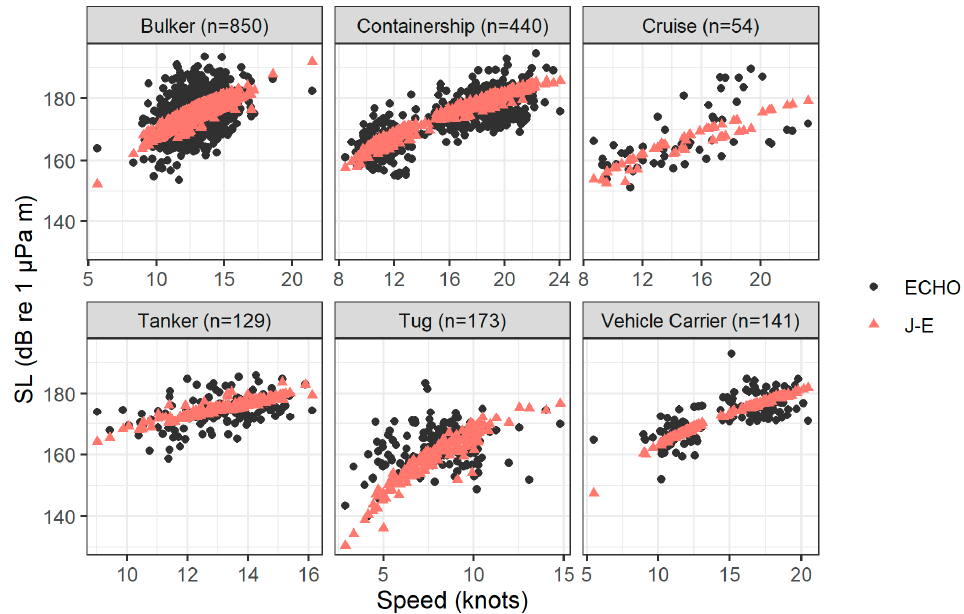
Figure 5. Scatter plots of predicted and observed (ECHO) source levels versus speed, in the 63 Hz decidecade band, for the JOMOPANS-ECHO (J-E) model, for six vessel types. The n value in each panel indicates the number of measurements for the specified vessel type.